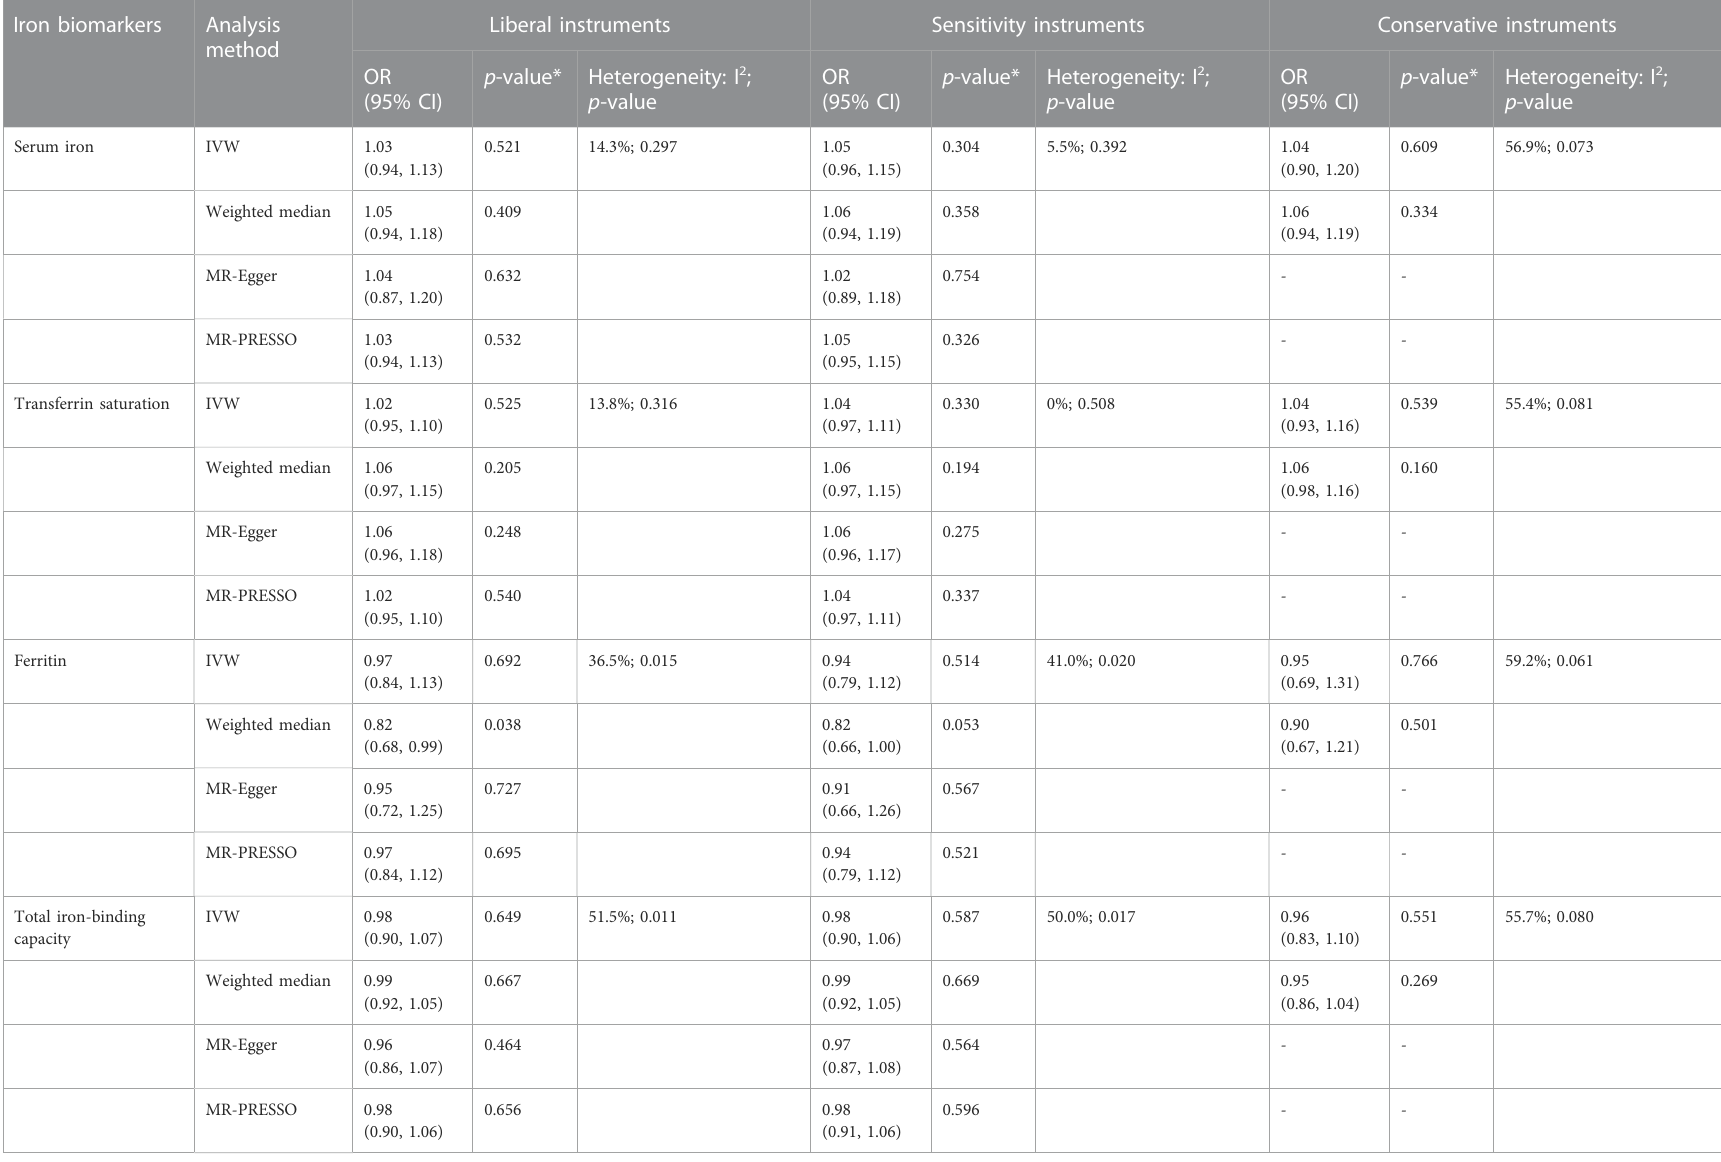
TABLE 3 Associations of the instrumental SNPs with four systemic iron status biomarkers and total knee